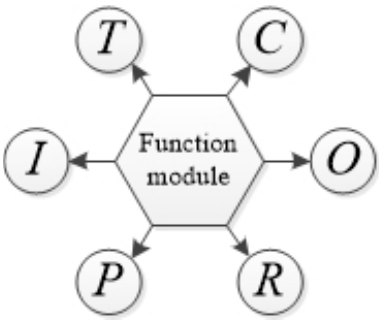
Figure 2. The FRAM functional